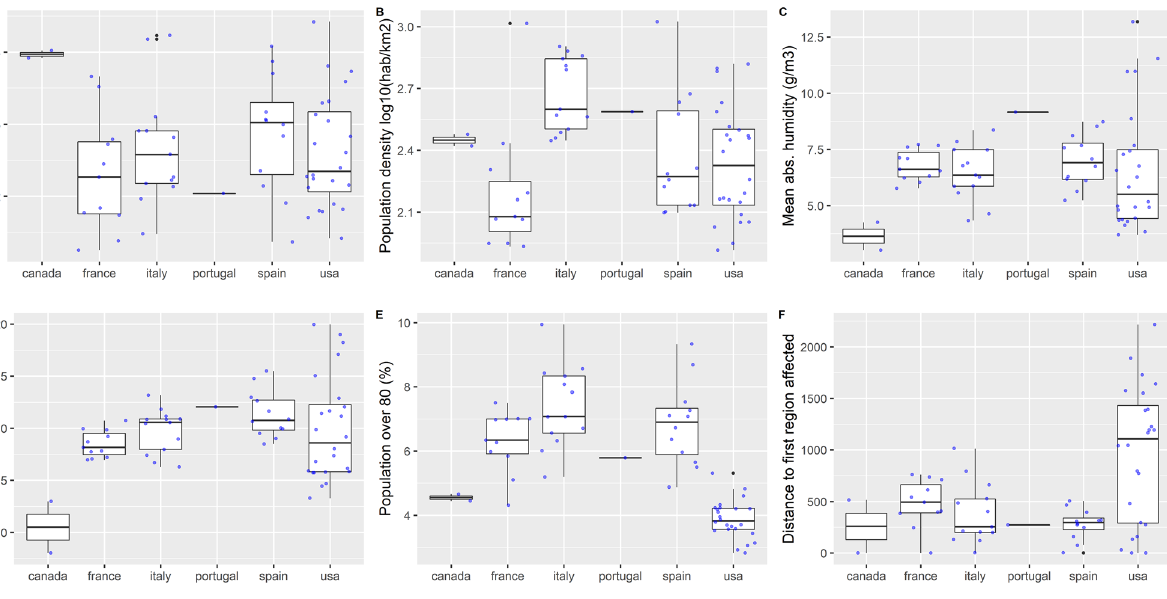
Figure 4. Distribution of R 0 and selected covariates by country. ( A ) R 0 , ( B ) population density (log10 inhabitants/km 2 ). ( C ) Mean AH (g/m 3 ). ( D ) Mean temperature (°C). ( E ) Population over 80 years old (%), ( F ) distance to the first region affected (km). The box represents the interquartile range and the median; whiskers correspond to the minimum between highest value and 1.5 IQR; black dots to outliers. All observations are ploted in light